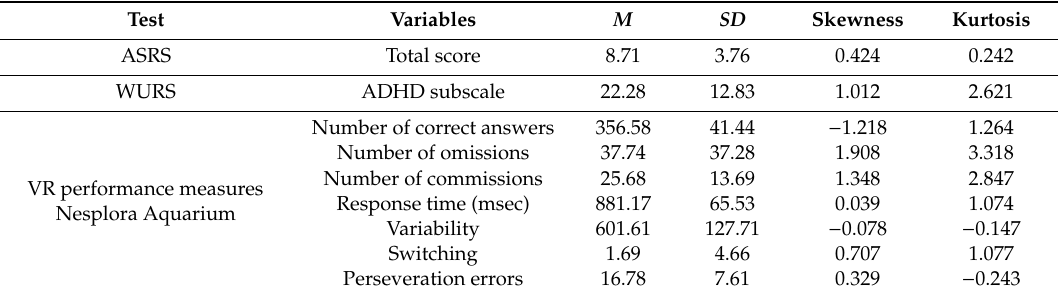
Table 1. Descriptive statistics for current symptoms (ASRS), retrospective symptoms (attention deficit hyperactivity disorder Wender Utah Rating Scale (ADHD-WURS)), and virtual reality (VR) performance